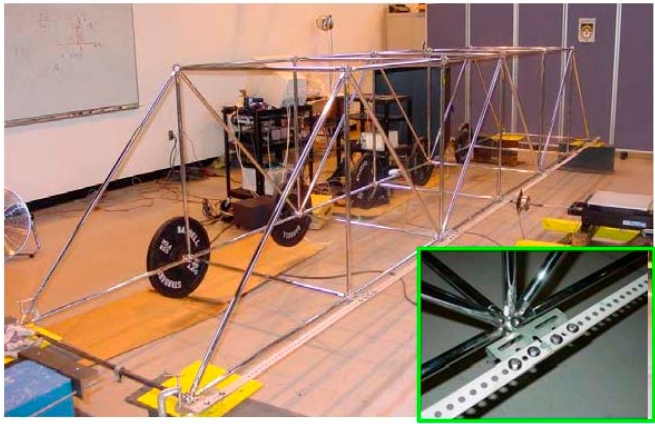
Figure 2. View of scaled steel bridge structure (inset shows the connection